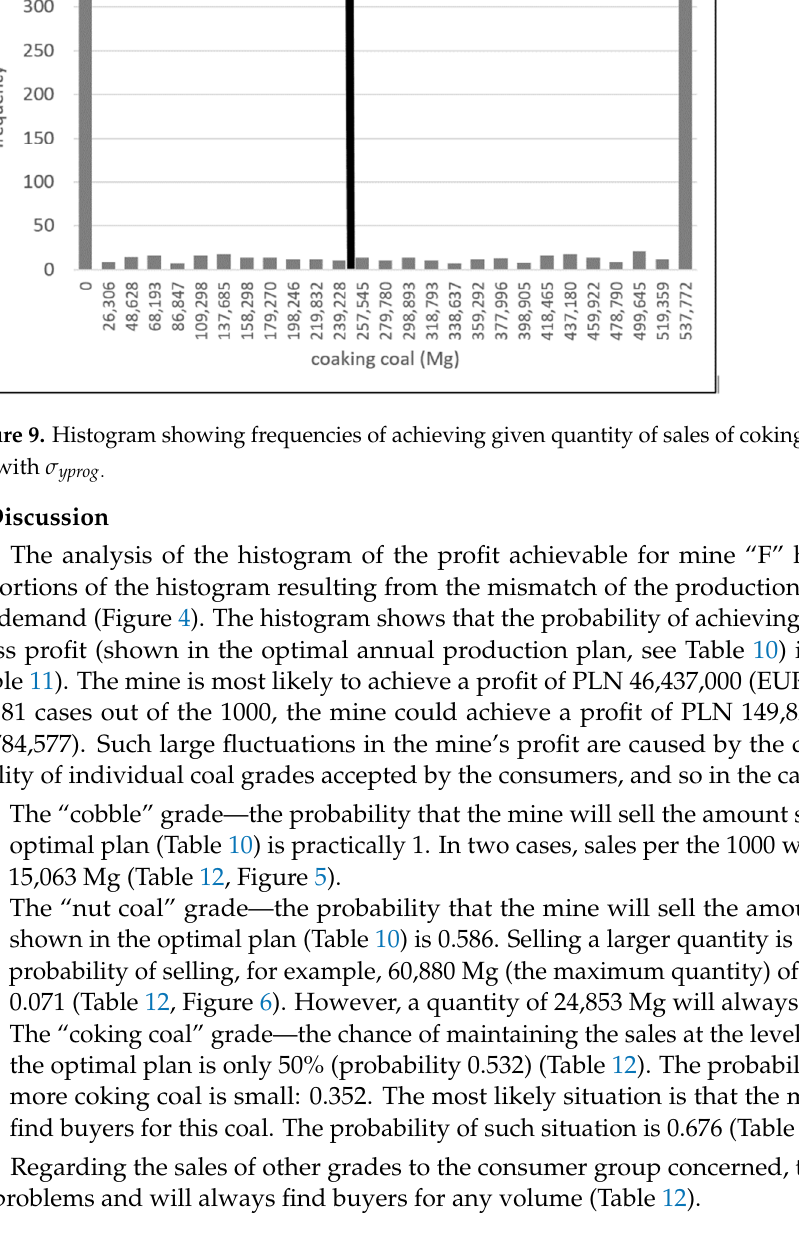
Figure 8. Histogram showing frequencies of achieving given quantity of sales of coal for mine “F” with σ yprog .